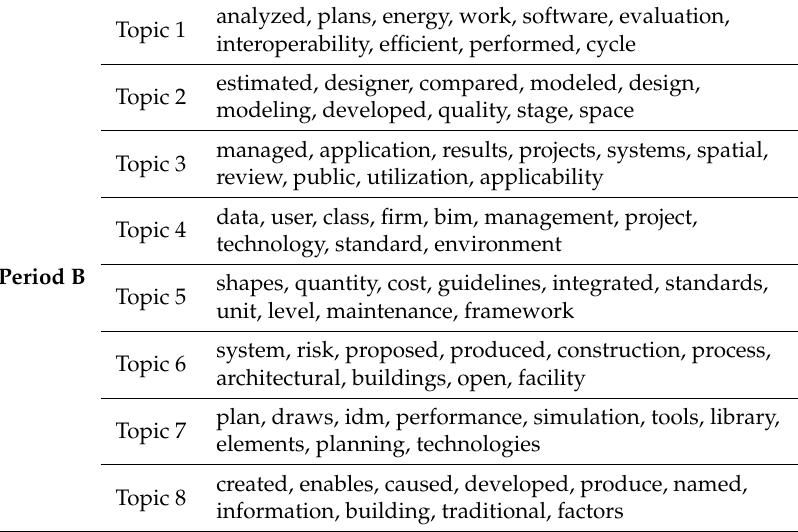
Table 6. Topic analysis result of Period B